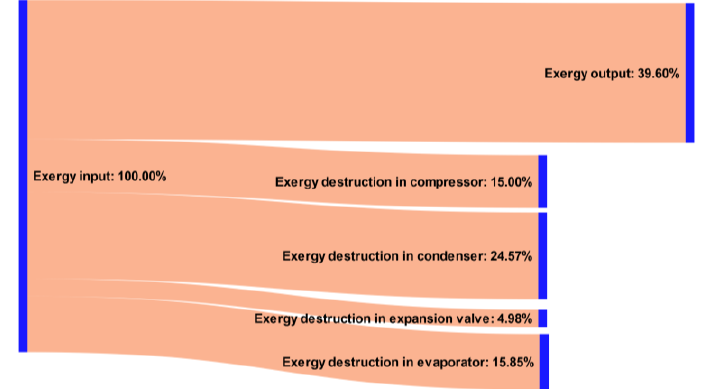
Fig. 5. Exergy destruction in single-stage compressor refrigeration